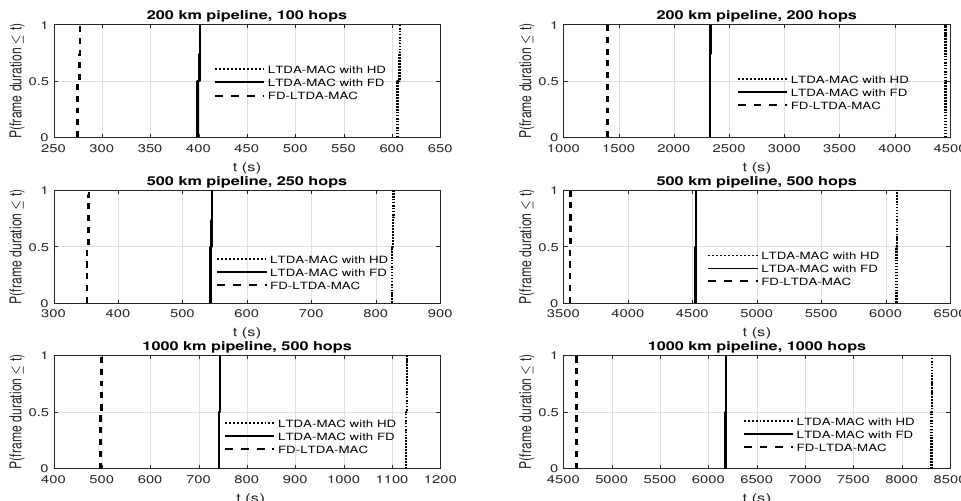
Figure 13. Frame duration cdfs of LTDA-MAC with HD nodes, LTDA-MAC with FD nodes, and FD-LTDA-MAC for large scale scenarios.